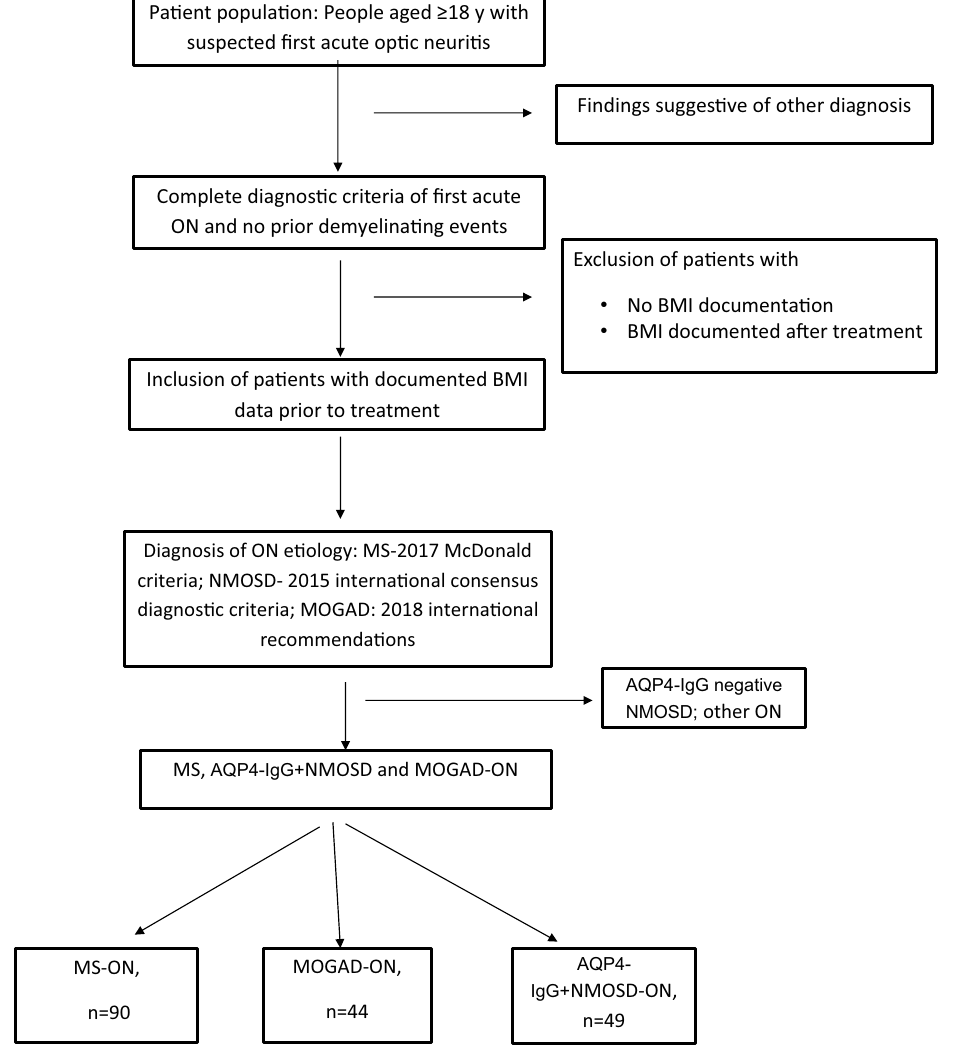
Figure 1. Patient selection and study design